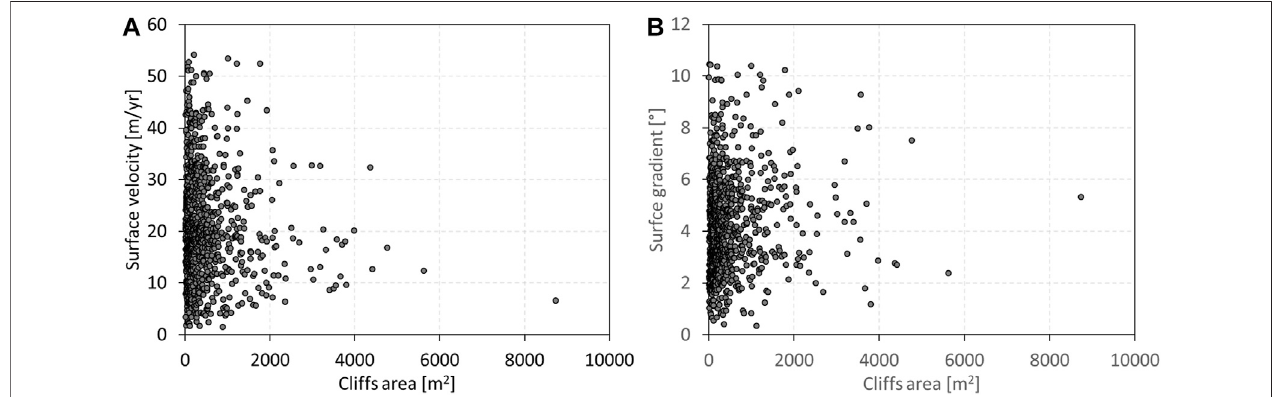
FIGURE 9 | Cliff area as a function of (A) surface velocity, derived from the spline interpolation, and (B) surface gradient, extracted from SRTM.